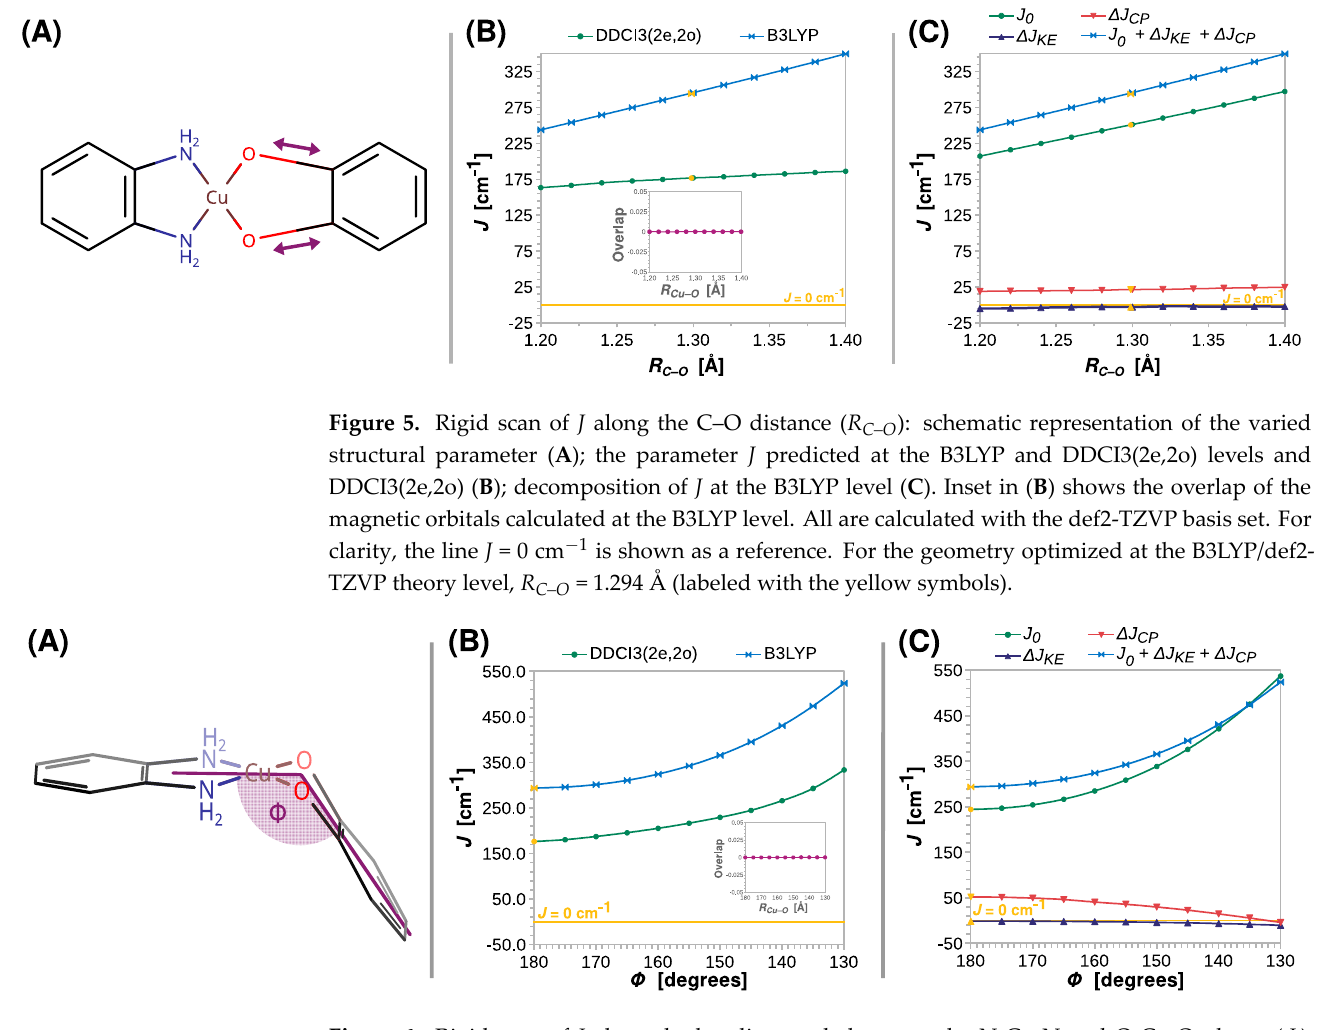
Figure 6. Rigid scan of J along the bending angle between the N-Cu-N and O-Cu-O planes ( Φ ): schematic representation of the varied structural parameter ( A ); the parameter J predicted at the B3LYP and DDCI3(2e,2o) levels ( B ); decomposition of J at the B3LYP level ( C ). Inset in ( B ) shows the overlap of the magnetic orbitals calculated at the B3LYP level. All are calculated with the def2- TZVP basis set. For clarity, the line J = 0 cm − 1 is shown as a reference. For the geometry optimized at the B3LYP/def2-TZVP theory level Φ = 0° (labeled with the yellow symbols).